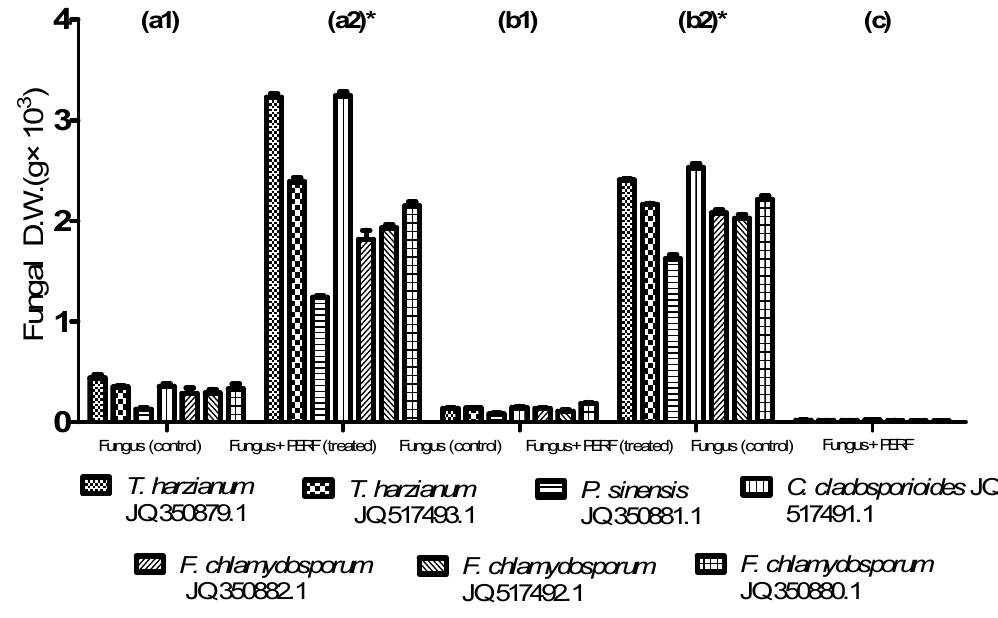
Figure 4. Dry weight (DW) of fungal strains grown in ( a1 ) PDB; ( a2 ) PDB + phorbol esters-rich fraction (PERF); ( b1 ) Mineral salts broth (MSB); ( b2 ) MSB + PERF and ( c ) PERF only after 30 days incubation. Treated media contained 2 g of PERF. The standard error bars were calculated from three replicates of each sample. * indicates significant difference between treated and control ( p <